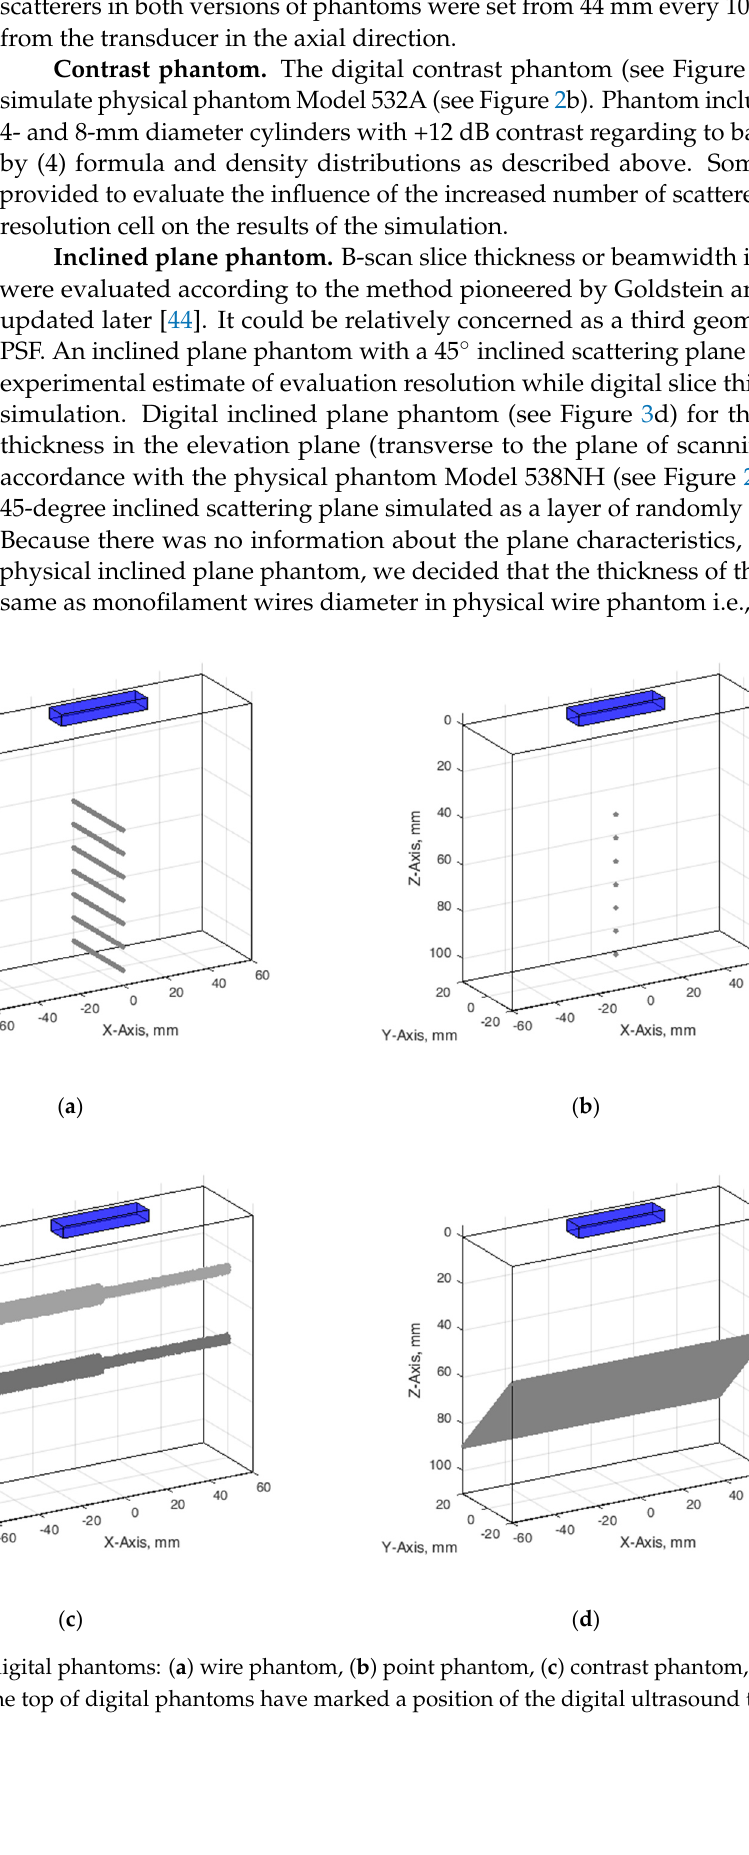
taken from the phantom’s documentation. 2.4. Physical Scanner The experimental scanning using all phantoms was provided for comparison with a digital simulation. It was done by a research-dedicated US scanner Ultrasonix Sonix Touch (Analogic Ultrasound, Richmond, BC, Canada), equipped with an SA4-2/24 planar phased array transducer. The scanner allows the acquisition of digitally beamformed US RF signals. The main parameters of US RF signal digitization and acoustic scanning were as follows: 16 bits analog-to-digital converter, 40 MHz sampling frequency, 2.52 MHz fre- quency of US waves, the number of transducer elements was 64, the number of post- beamformed scanning lines was set to 131, and the echoscopy depth and transmit focal depth were set to 11 cm and 7 cm accordingly. The phased array transducer sector com- posed a 63-degree angle, which ensures a higher frame rate to capture pulsing tissues dynamics in vivo in future studies. The speed of sound in the scanner and for the pro- cessing of the US RF signals was set to 1540 m/s.